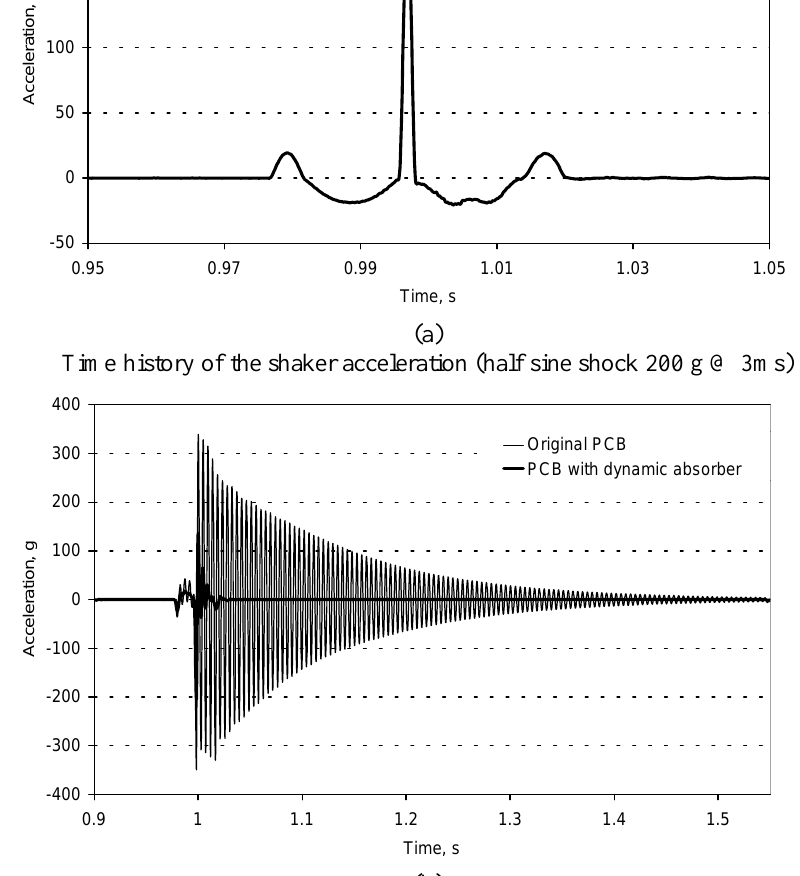
dynamic responses measured at the critical point of the PCB before and after mounting the dynamic